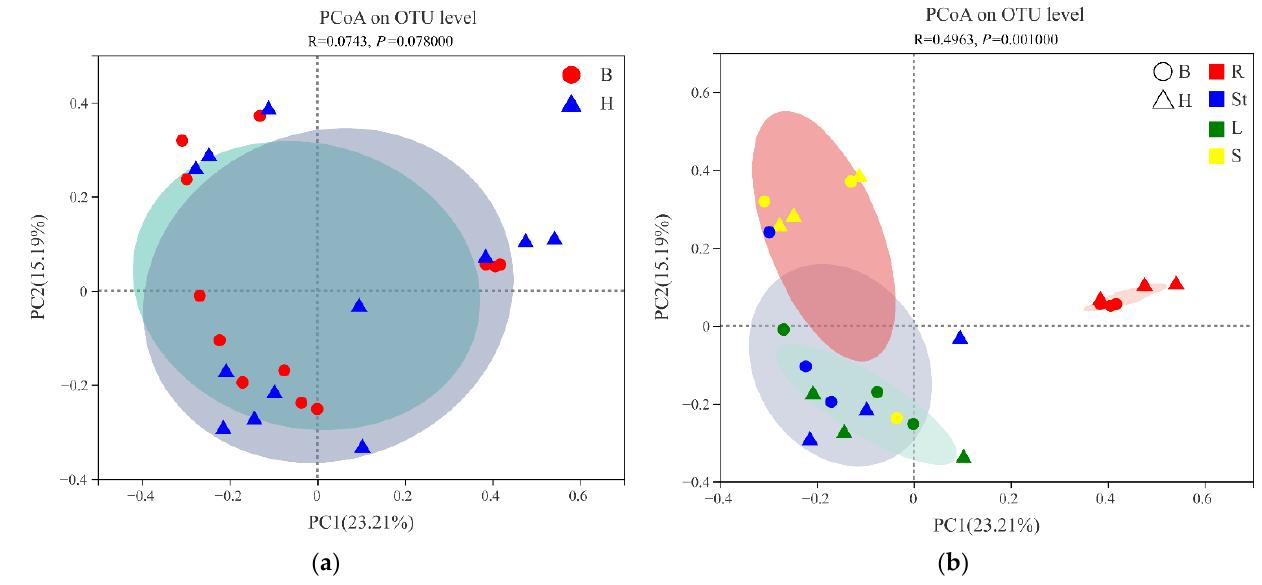
Figure 2. Principal coordinates analysis (PCoA) based on the relative abundance of fungal OTUs showing the fungal community structure: ( a ) in different sample sites: B (Circular), H (triangle); ( b ) in four organs: R (red color), St (blue color), L (green color), S (yellow colors). Table 2. Adonis pairwise comparisons of microbiota structure between sites and organs of S. alopecuroides .